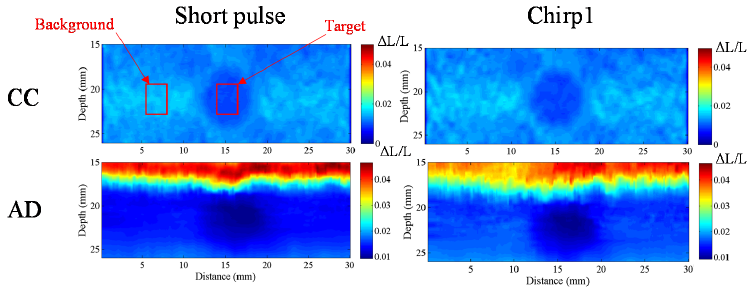
Figure 20. A strain image of short pulse and chirp pulse by CC and AD, respectively. The pulse length of chirp is 20 cycle. The correlation window length is 0.77 mm and applied strain is 1% are fixed.